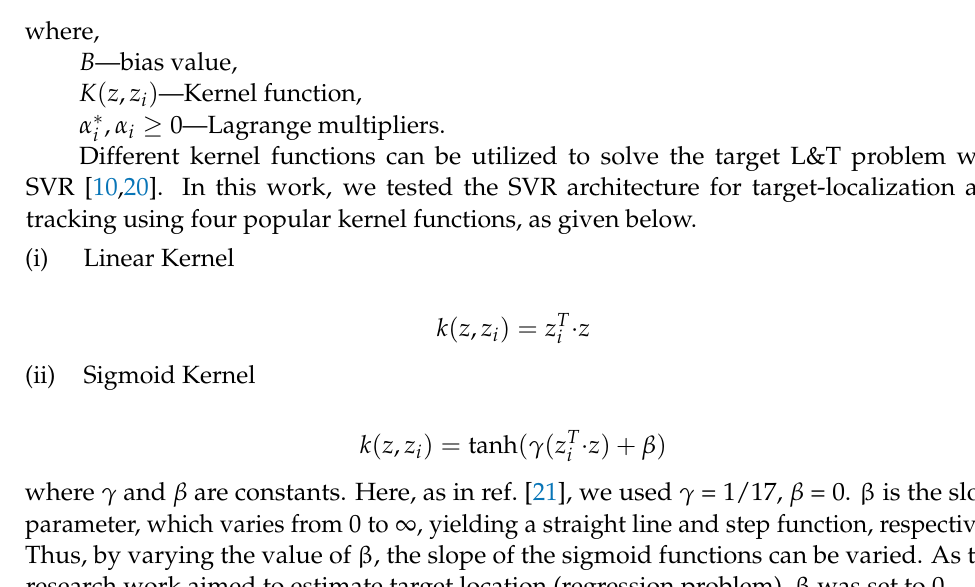
Table 1. Location of the ANs in the considered WSN-defined area. Anchor Node Number